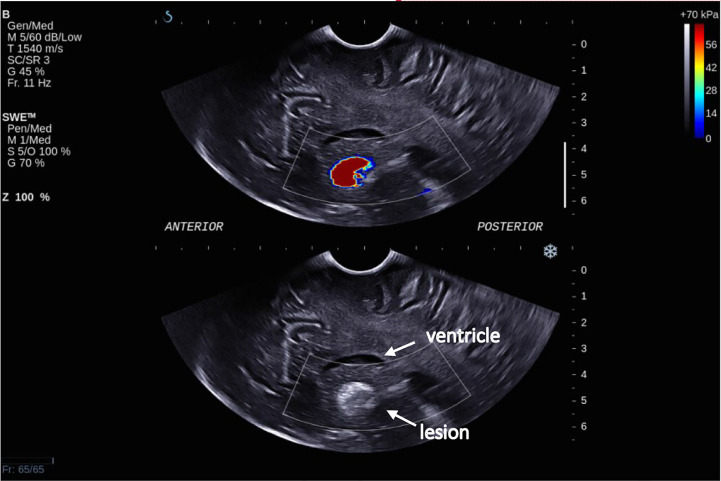
Intra-operative SWE for Patient 8 showing the tumor lying under the ventricles at a depth of 5 cm from the transducer. There was a lack of SWE signal in the adjacent brain. This scan was acquired using the sector probe (SE12-3) insonating in the sagittal plane. The histology of this lesion again is subependymal giant cell astrocytoma (SEGA).